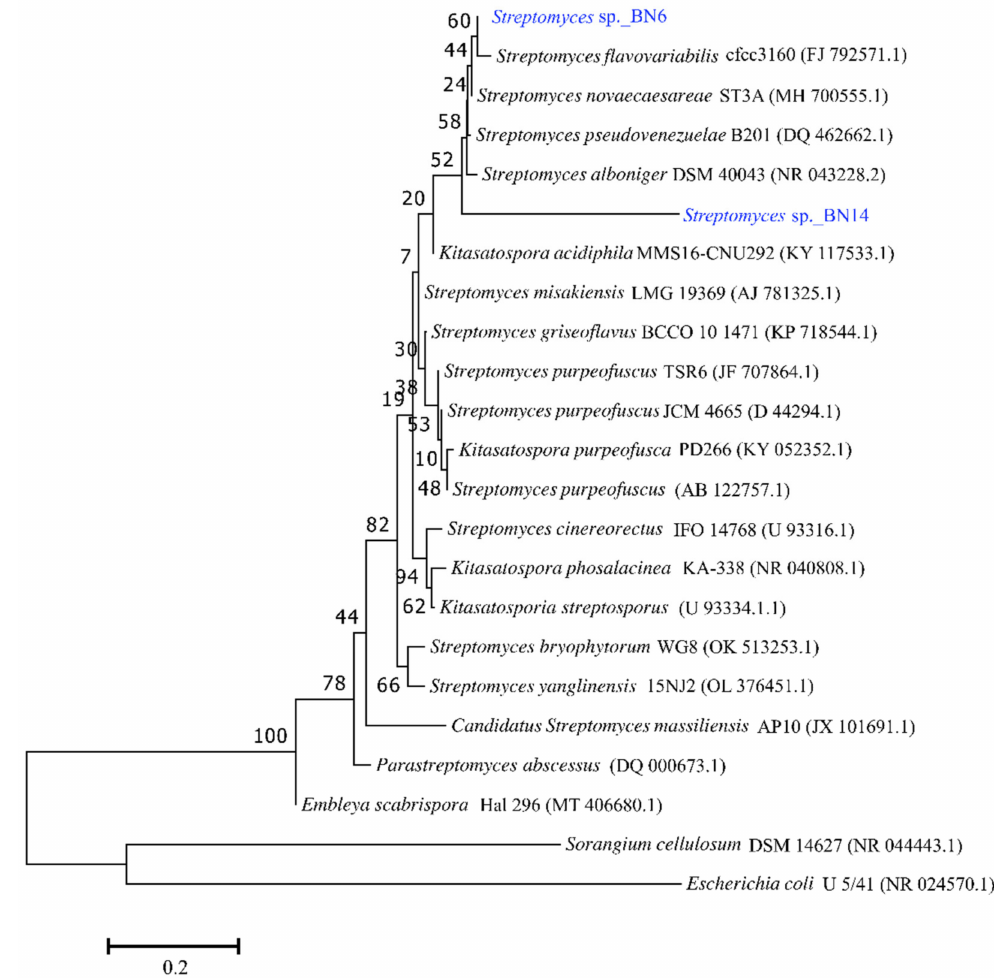
Figure 3. Neighbor-joining phylogenetic tree of 16S rRNA of isolates BN6 and BN14. Horizontal branch lengths proportional to the estimated number of nucleotide substitutions, and bootstrap probabilities (as percentages), as determined for 1000 resamplings, are given above and beside the internal branches. The bar in the lower-left corner indicates 0.20 substitutions per nucleotide position. Genebank accession numbers are shown in parentheses. Sorangium cellulosum DSM 14627 (NR 044443.1) and Escherichia coli U 5/41 (NR 024570.1) were used as an outgroup to root the